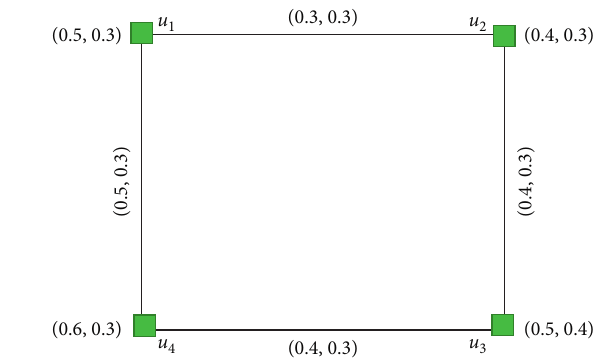
Figure 1: Intuitionistic fuzzy